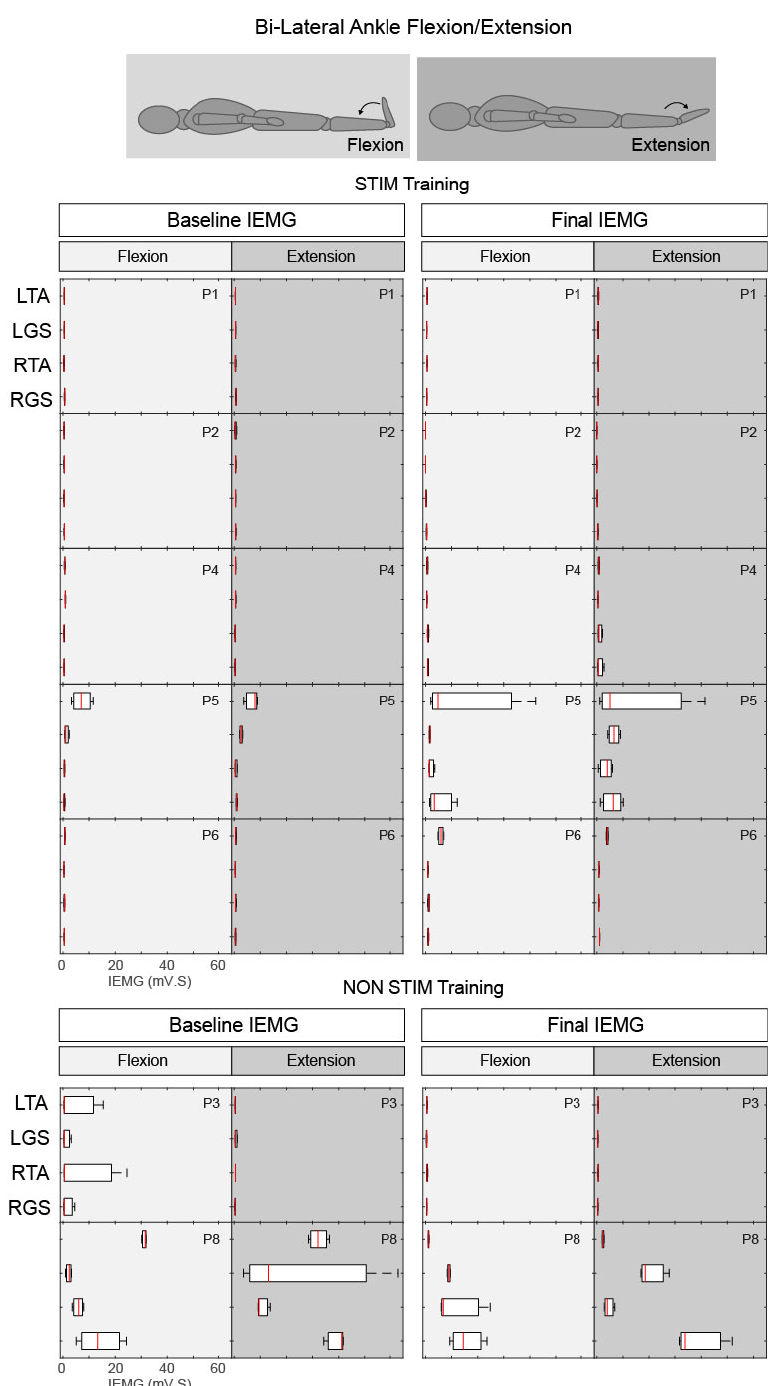
(AIS A, STIM group) and P8 (AIS C NON-STIM group) displayed increased tonic firing (see P6 LTA Figure 7e,f; P8 LGS and RGS Figure 7g,h) post training compared with pre.